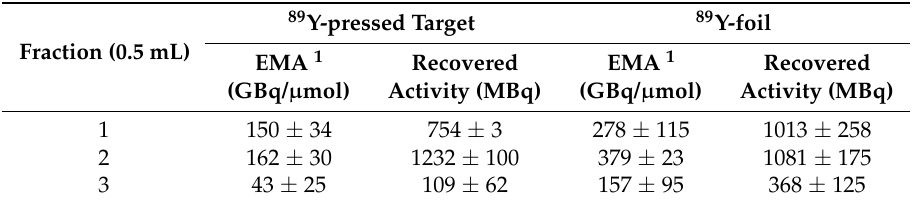
Table 3. EMA values and activities for 89 Y-pressed target and 89 Y-foil.